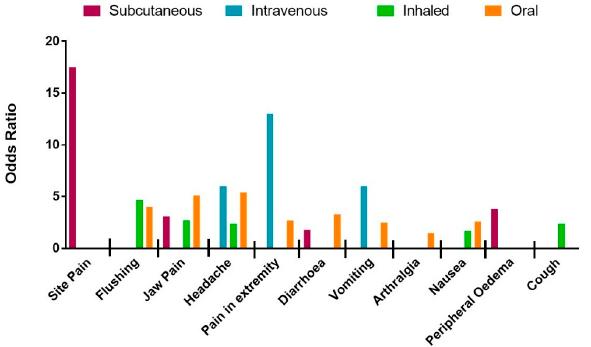
Figure 2. Likelihood, measured by odds ratio, of experiencing each adverse event during trial period associated with prostacyclin mimetic therapy as analysed by route of administration (subcutaneous infusion, intravenous infusion, inhaled therapy and oral tablet.